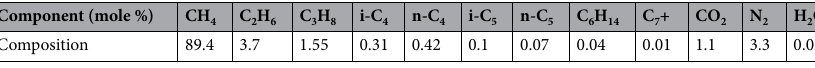
Table 1. The natural gas